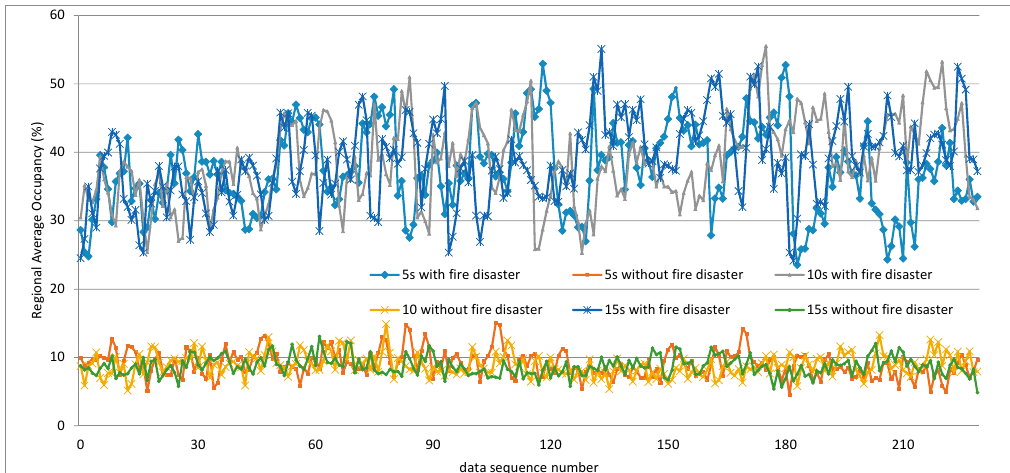
Figure 5. Dataset of regional average occupancy in different collecting time intervals with and without sudden fire disasters.